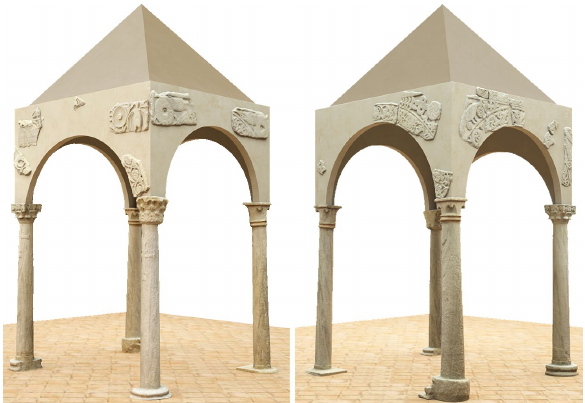
Figure 7. 3D model of the ciborium – view of the four arcades